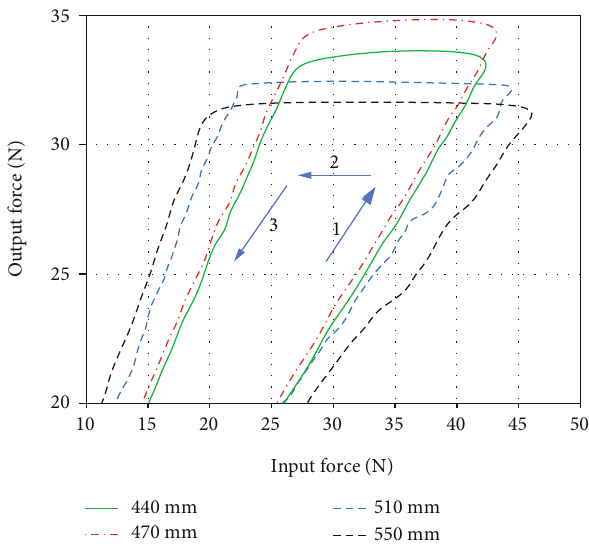
Figure 12: The variation of force transmission with various lengths of Bowden cable.